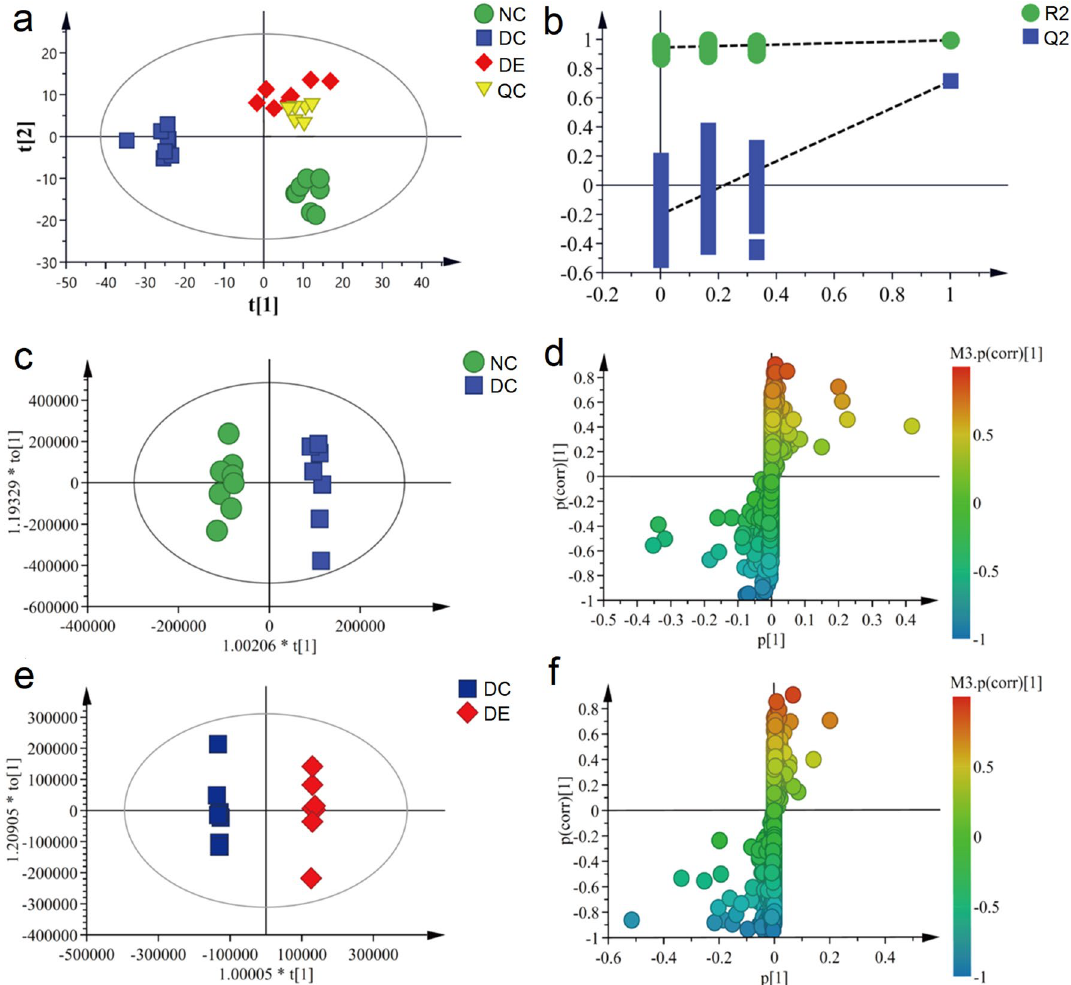
Figure 2. Multivariate data analysis from LC–MS/MS. ( a ) PLS-DA score plots from group NC, group DC, group DE, and QC; ( b ) PLS-DA model validation diagram; ( c ) OPLS-DA score plots from group NC and group DC; ( d ) S-plot of group NC and group DC; ( e ) OPLS-DA score plots from group DC and group DE; ( f ) S-plot of group DC and group DE. QC Quality control, PLS-DA partial least squares discriminant analysis, OPLS-DA Orthogonal partial least squares discriminant